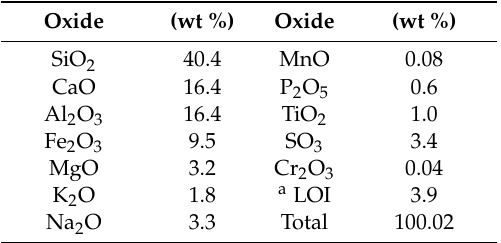
Table 1. Chemical composition (wt %) of fly ash